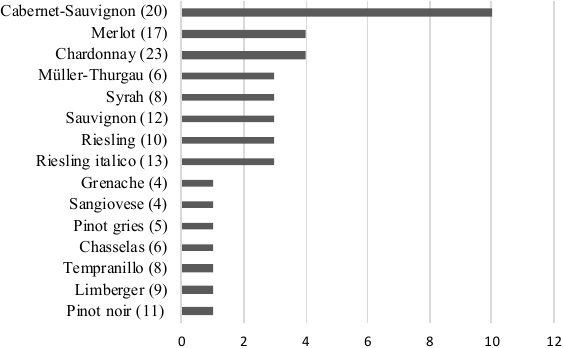
Figure 4 Numbers of survey response reports on cultivar suscepti- bility to esca complex (Total report number in